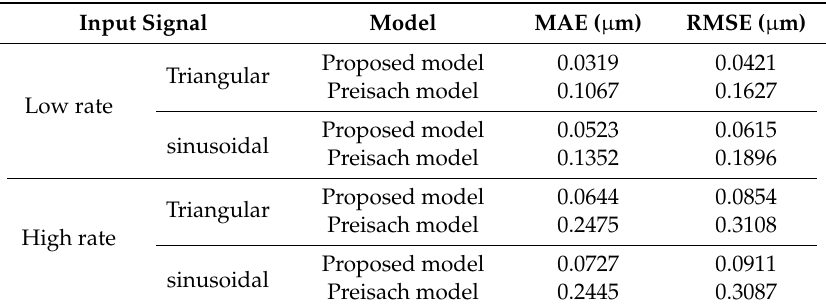
Table 7. The modeling errors with sinusoidal